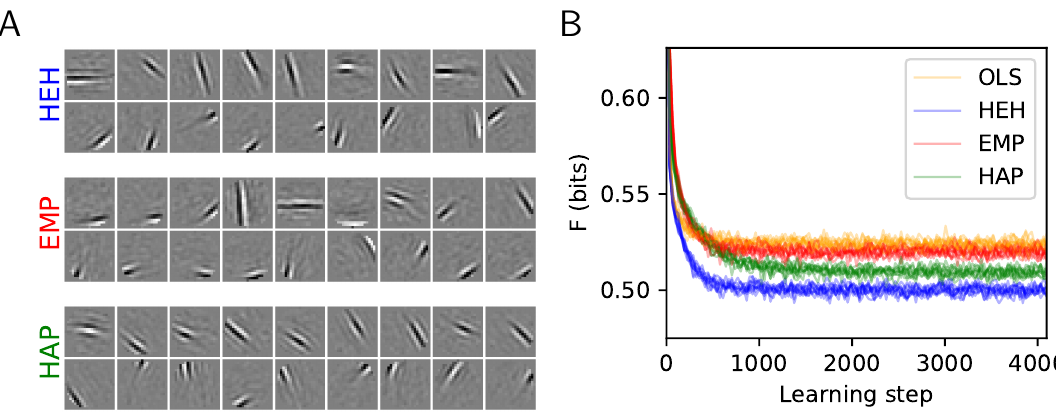
Figure 3. Homeostasis on Activation Probability ( HAP ) and a quantitative evaluation of homeostatic strategies. ( A ) The plot shows 18 from the N = 676 dictionaries learned for the two heuristics EMP and HAP and compared to the optimal homeostasis (see Figure 1A, HEH ). Again, the upper and lower row respectively show the least and most probably selected atoms. ( B ) Comparison of the cost F during learning and cross-validated over 10 runs: The convergence of OLS is similar to EMP . The simpler HAP heuristics gets closer to the more demanding HEH homeostatic rule, demonstrating that this heuristic is a good compromise for fast unsupervised